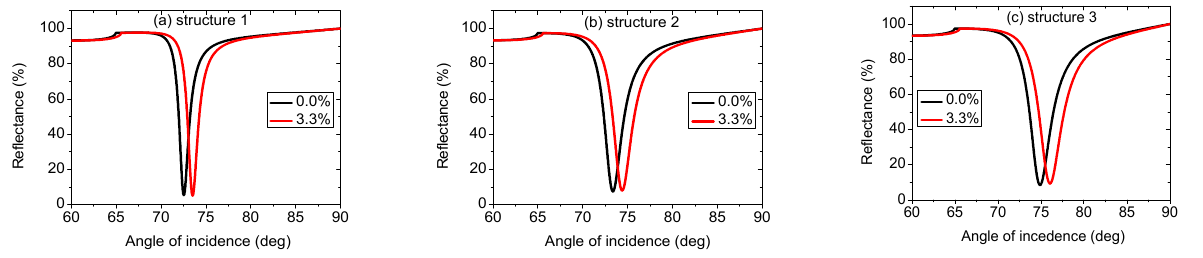
Figure 2. Reflectance curves of ( a ) prism/Ag/analyte medium, ( b ) prism/Ag/Ti 3 C 2 T x /analyte medium, and ( c ) prism/Ag/Si/Ti 3 C 2 T x /analyte medium. Table 2. The used structures and their performance parameters at d Ag = 50 nm, d S = 1 nm, and d M = L × 0.993 nm where L =